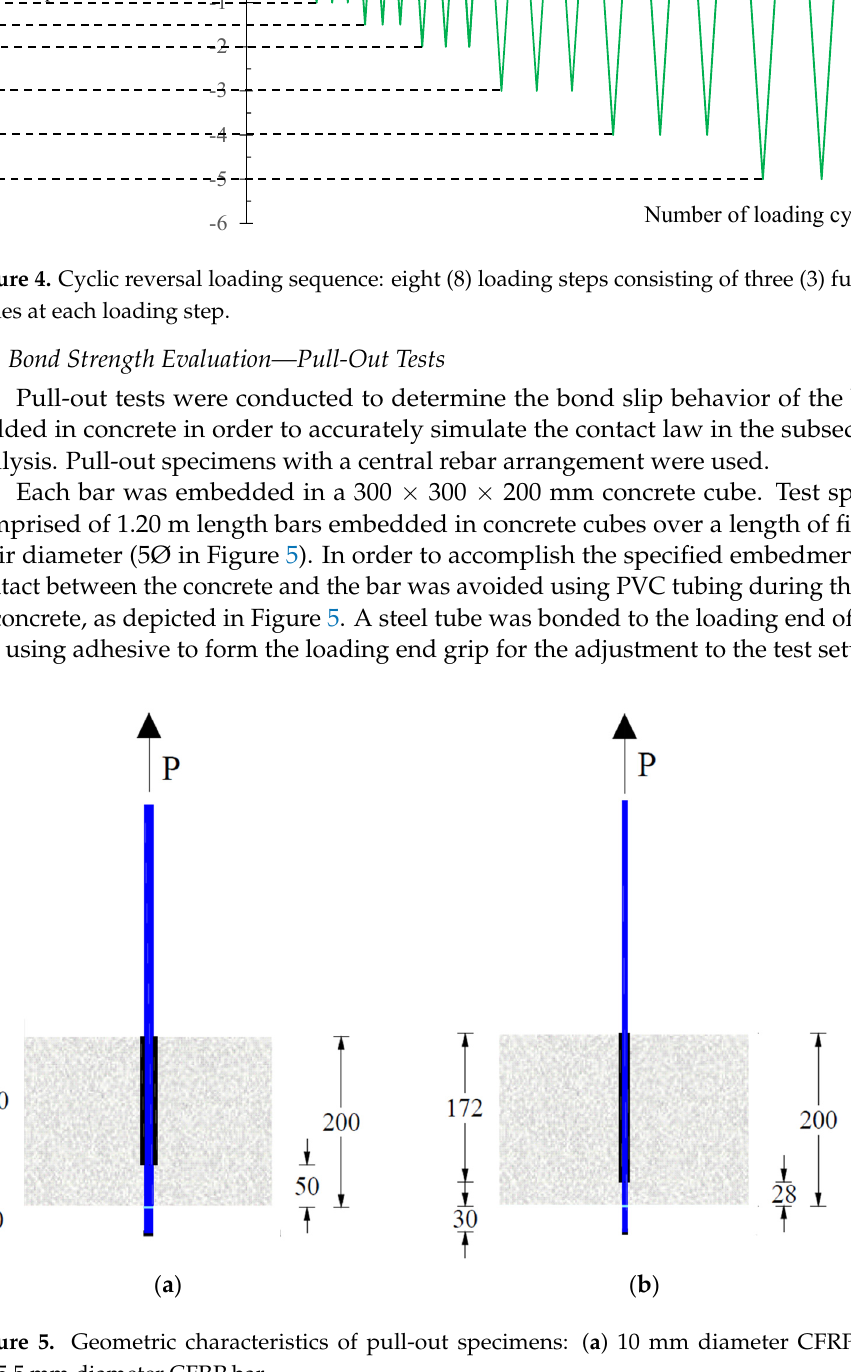
Figure 6. Test setup of pull-out specimens.